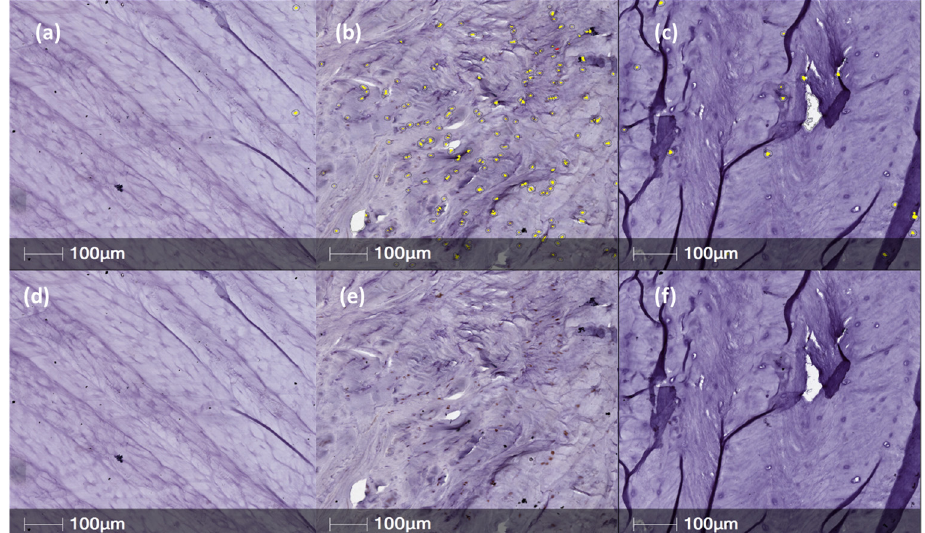
Figure 4. Representative samples for TrkB immunostaining of normal, PBS (n = 11) and NTG-101 (n = 6) injected canine IVDs. ( a – c ) Yellow overlay over immunopositive cells as well as only DAB immunopositive cells are shown in top and bottom panels, respectively ( d – f ).